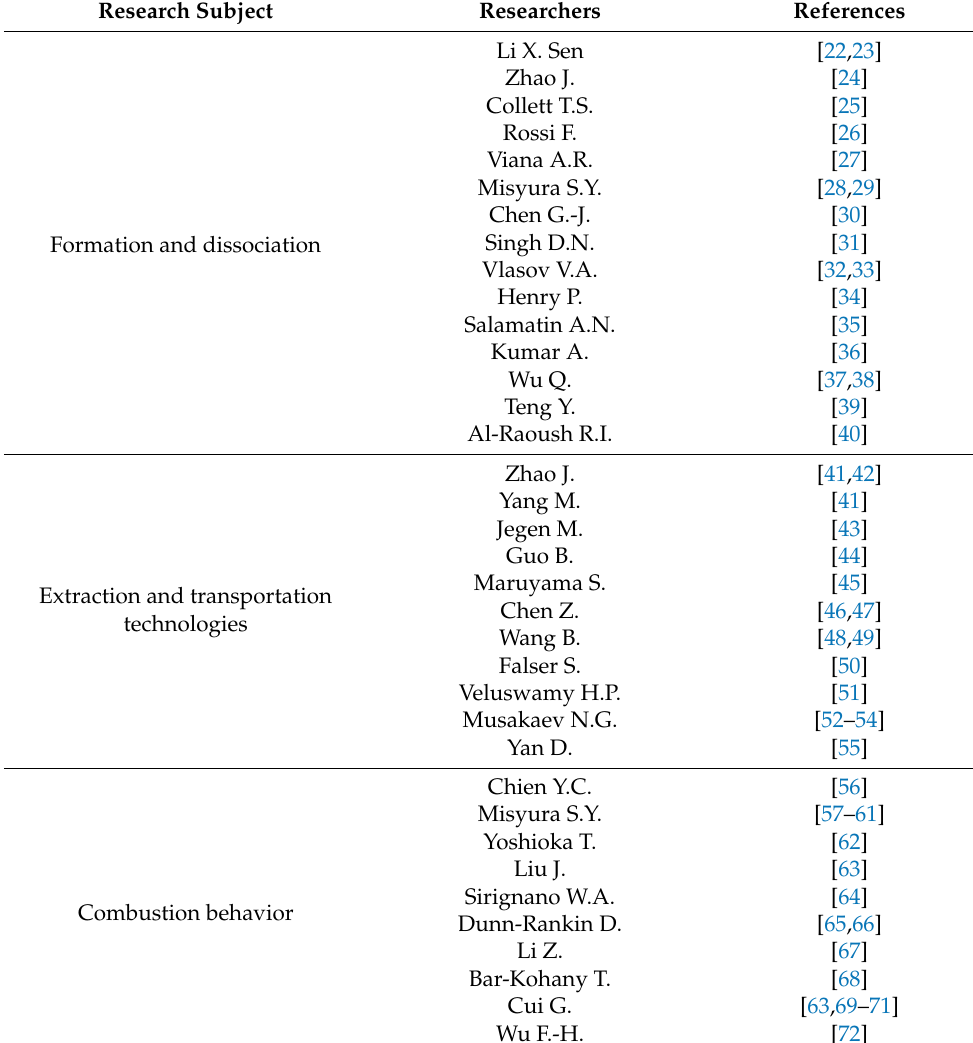
Table 1. Examples of research on gas